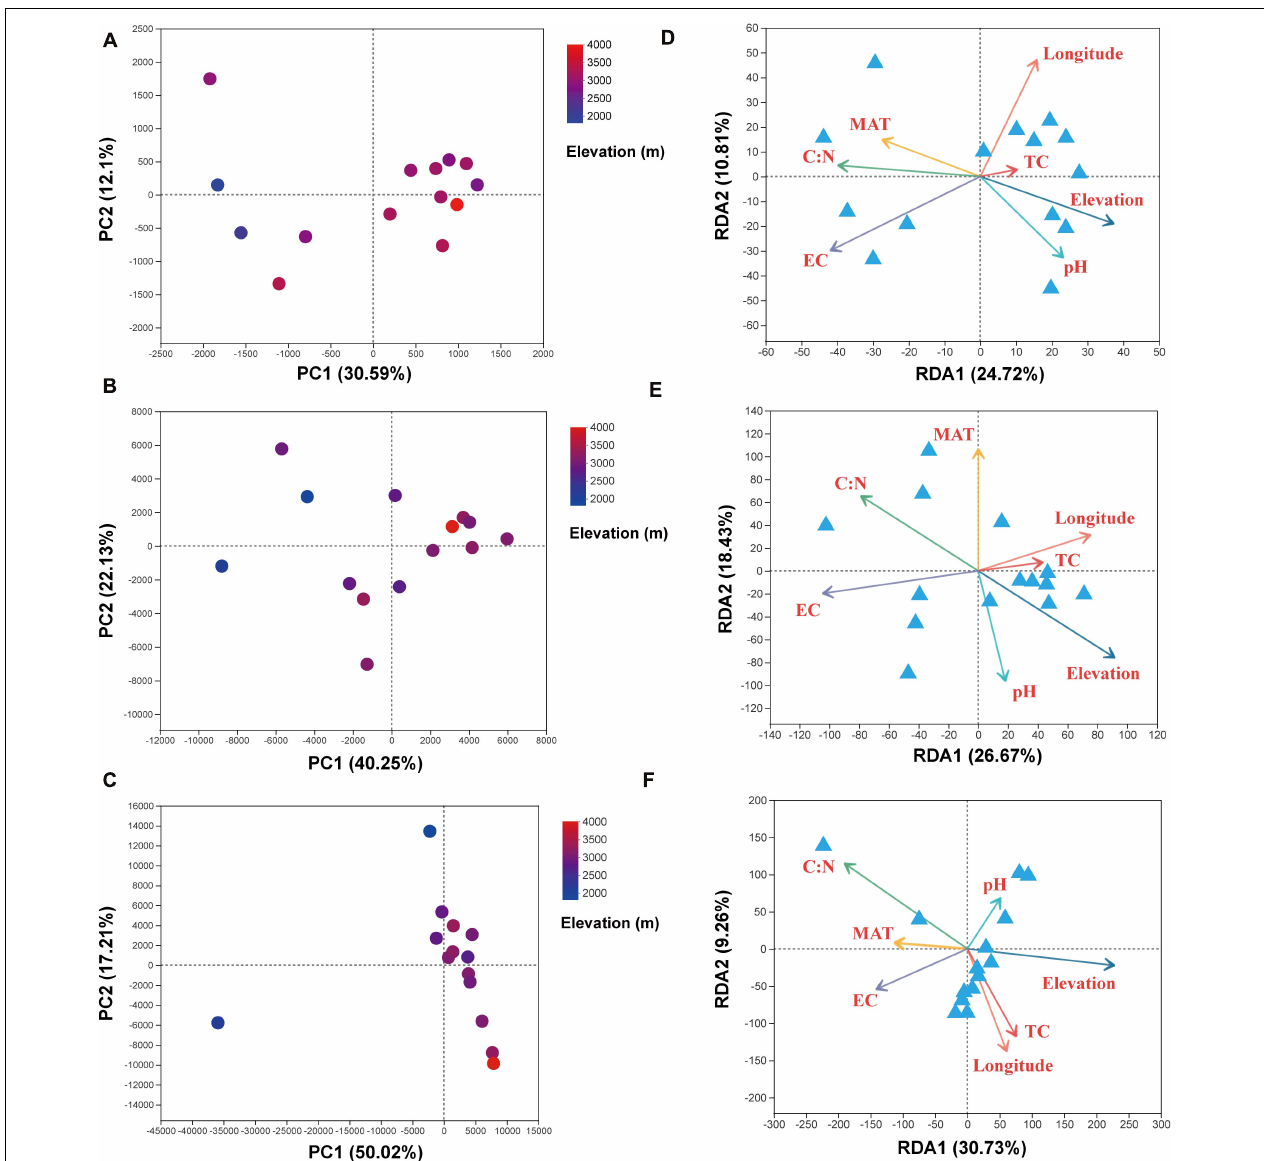
FIGURE 4 | Results of the principal components (PC1 and PC2) analysis for the soil (A) bacterial, (B) archaeal, and (C) eukaryota communities and redundancy analysis results (RDA1 and RDA2) for the soil (D) bacterial, (E) archaeal, and (F) eukaryota community diversity and the environmental variables. Variables: MAT, mean annual temperature; MAP, mean annual precipitation; EC, electrical conductivity; TC, total carbon; TN, total